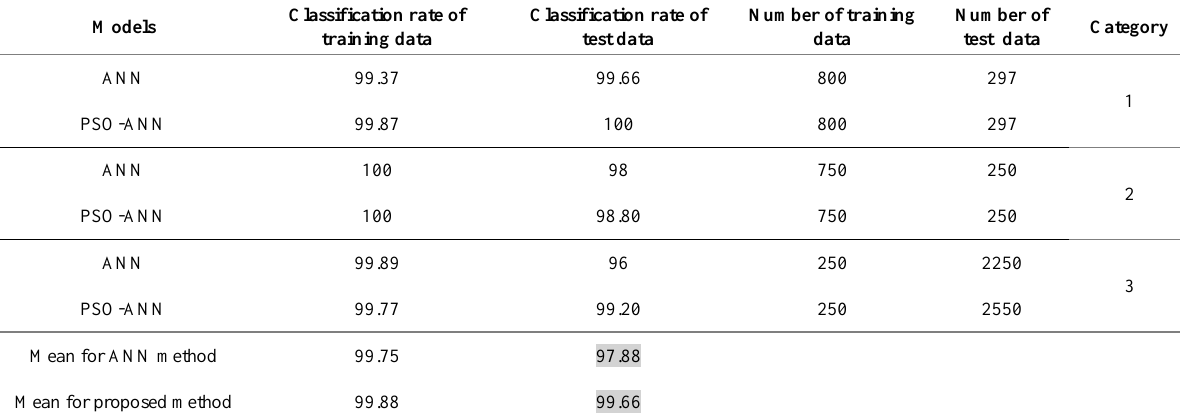
Table 1. Obtained results from the three classes by the proposed model and the perceptron neural network.